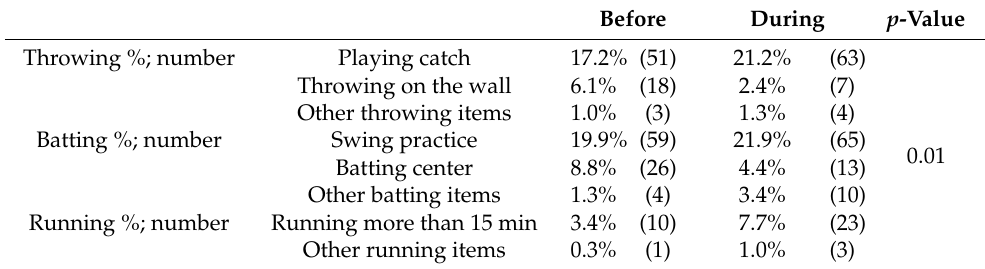
Table 4. Item changes in voluntary exercise-related baseball ( n =